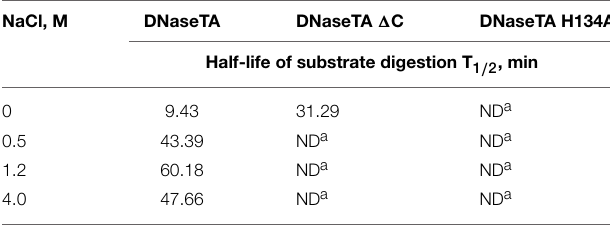
TABLE 2 | The half-life of the radioactive substrate digestion of the recombinant DNase from Thioalkalivibrio sp. K90mix (DNaseTA) and its